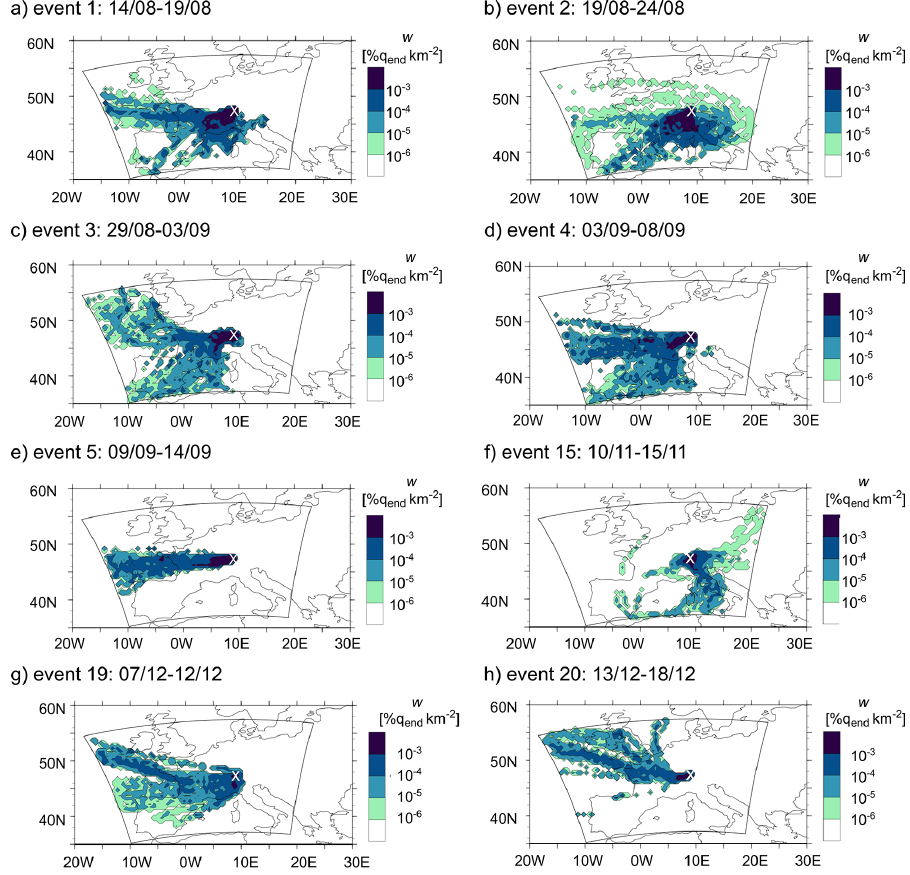
Fig. 9. Integrated moisture sources diagnosed for the HRA events 1 to 5, 15, 19 and 20 discussed in the text. The colour coding indicates percental contribution to the final specific humidity per km 2 ( w ). The integral over the entire moisture source region sums up to 100% of the explained moisture at the Rietholzbach site (white